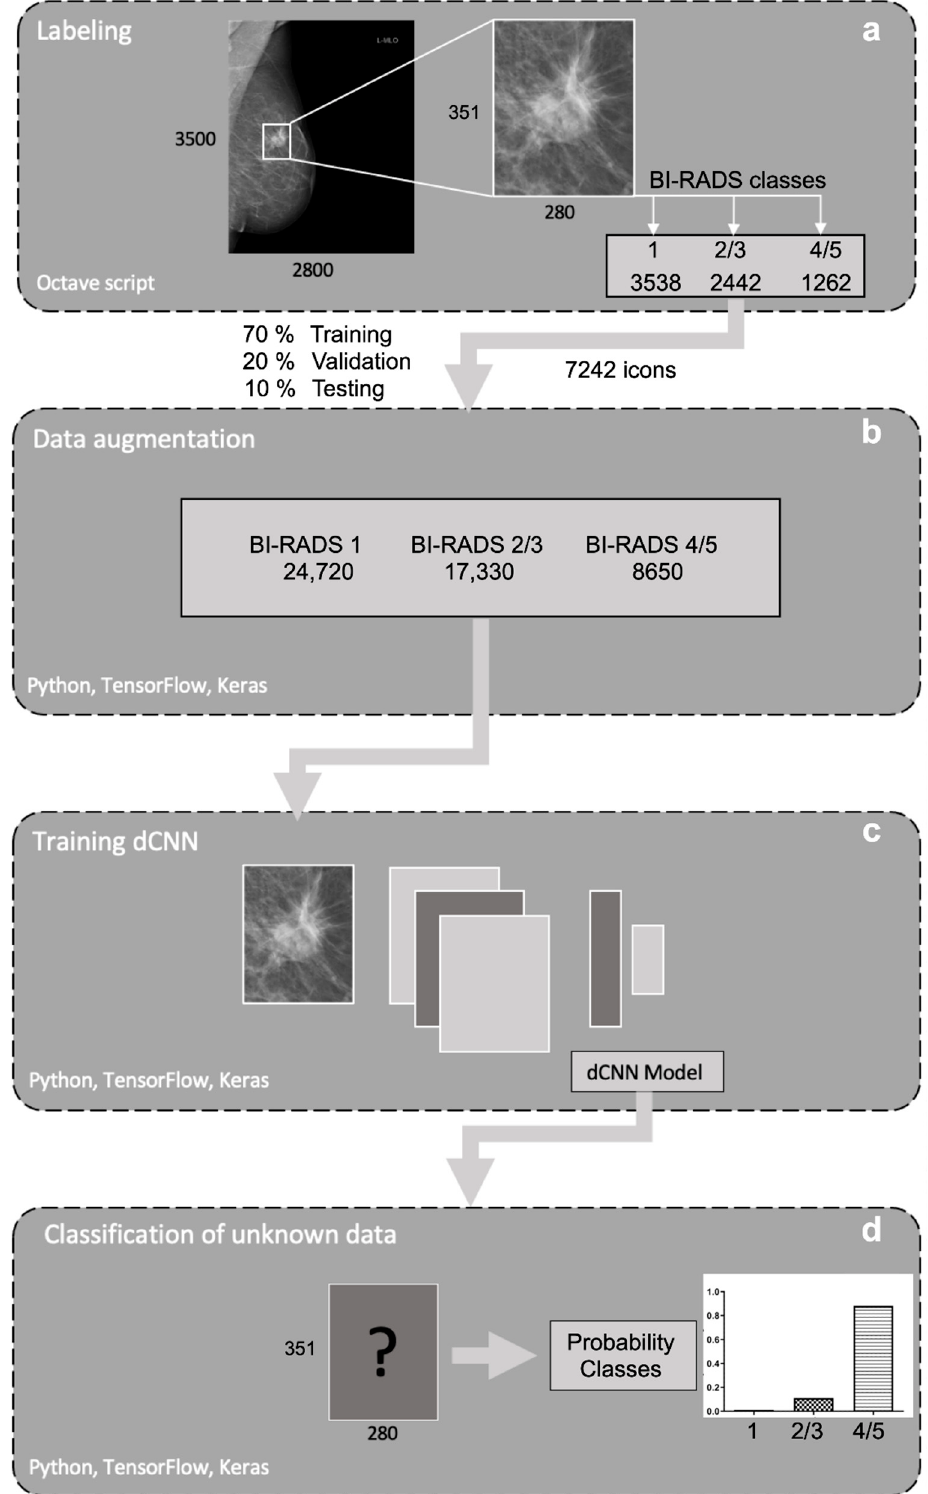
Figure 4. Schematic pipeline of the workflow used. ( a ) First mammograms were resized. For each image, different rectangular regions of interest (ROIs) were generated and labeled to three defined BI-RADS classes: “healthy tissue” (1), “probably benign opacities” (2/3) and “suspicious opacities” (4/5). ( b ) Data was randomly augmented with a built-in ImageDataGenerator class of Keras. ( c ) After image preprocessing and data augmentation, four different dCNN models were trained, validated and tested, ( d ) classifying the generated images based on the probability for the different BI-RADS classes.